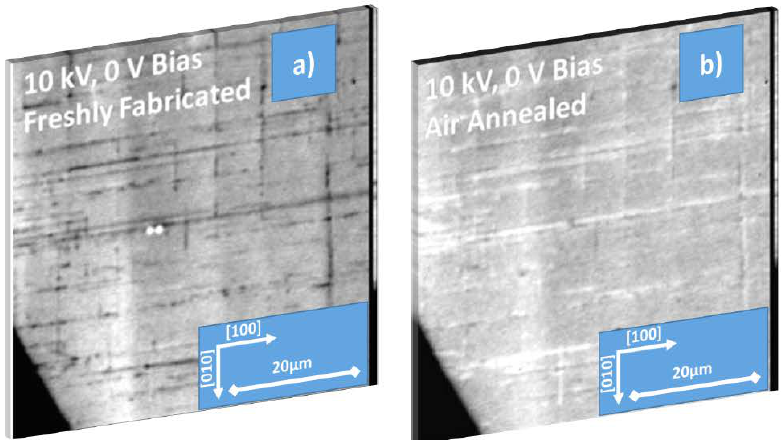
Figure 46. Maps of the electronic beam induced contrast in the surface region between reduced SrTiO 3 − x and Pt thin films (~100 nm). Electron Beam Induced Current (EBIC) investigation was obtained with energy 10 keV. ( a ) was imaged immediately after fabrication; ( b ) after annealing the contact in air at 120 °C for 10 min. Adapted from [242].